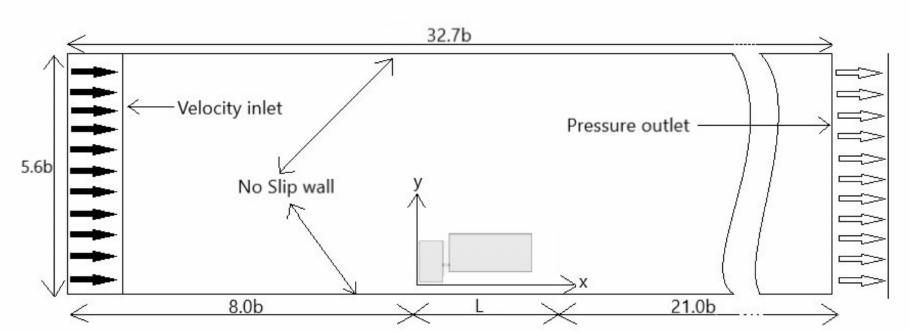
Figure 3. Computational